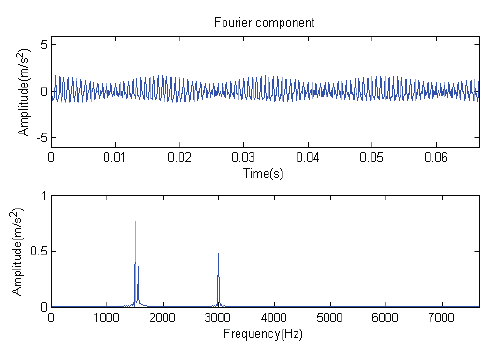
Figure 17. Fourier